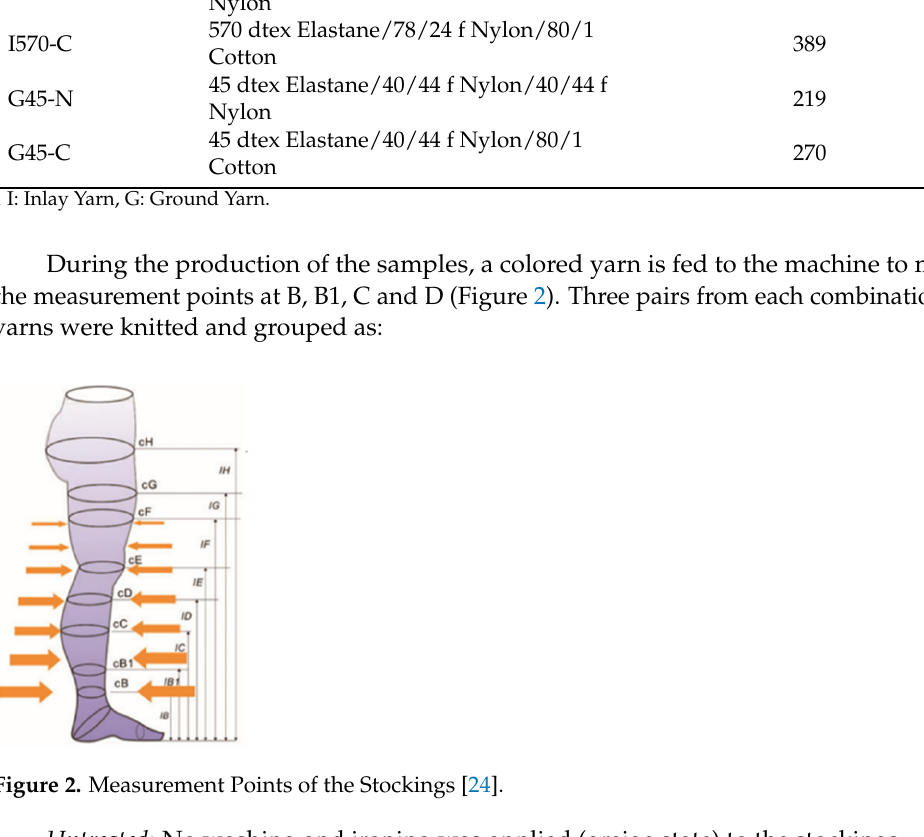
Table 2. Details and Elongation of Double covered yarns under fixed load. Yarn code1 Yarn Count (Core/1st Cover/2nd Cover)